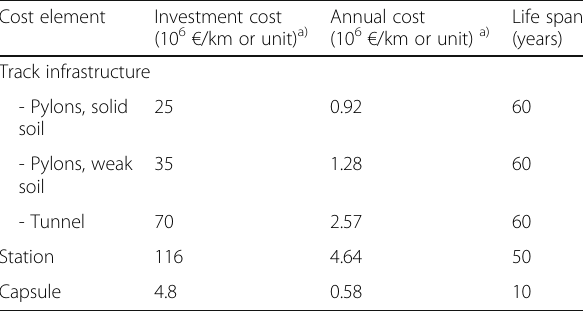
Table 3 Investment and annual capital cost for the HL system infrastructure and